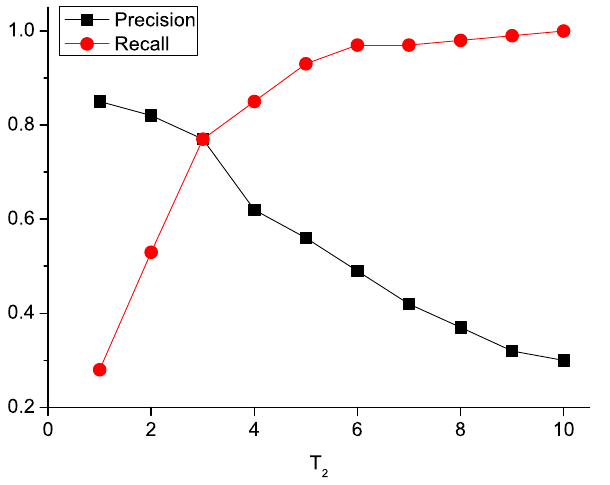
Fig. 6 Recall and precision on different T 2